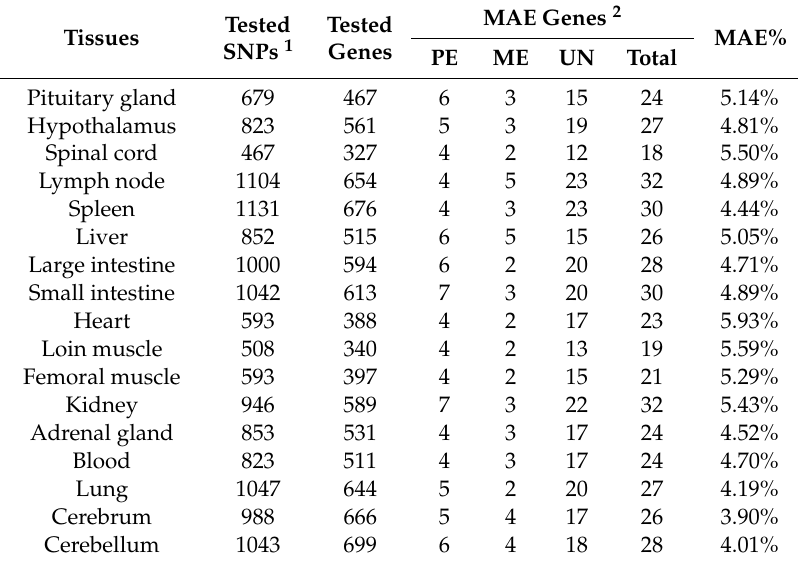
Table 1. Summary of monoallelically expressed genes in tested